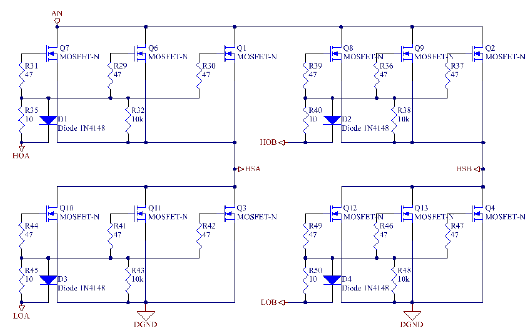
Fig. 2. H-bridge of single-phase power inverter.